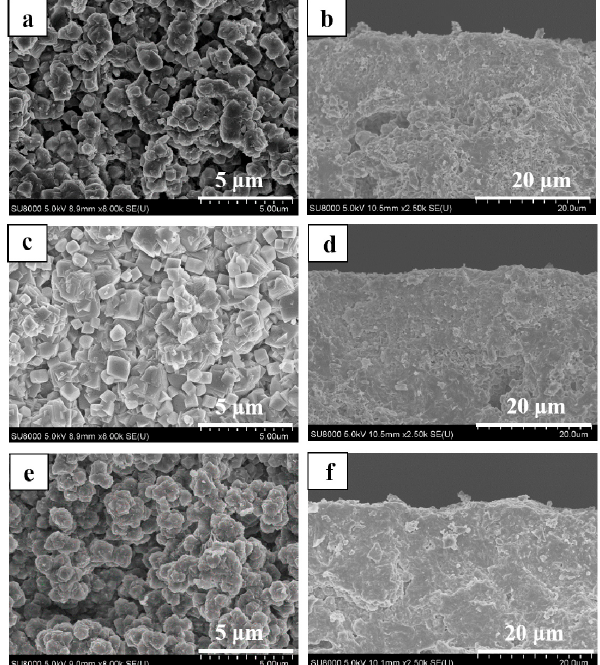
Figure 3. Surface and cross-sectional SEM images of high silica SSZ-13 zeolite membranes with different SiO 2 /Al 2 O 3 ratio ( a , b ) M-1, SiO 2 /Al 2 O 3 = 40; ( c , d ) M-2, SiO 2 /Al 2 O 3 =200; ( e , f ) M-3, SiO 2 /Al 2 O 3 = ∞